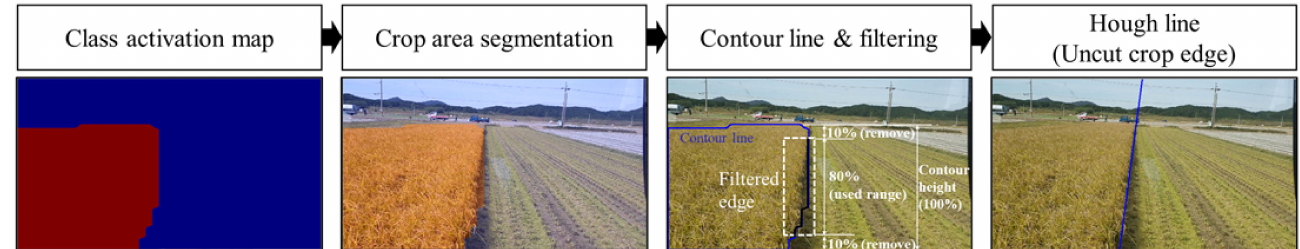
Figure 3. Image processing for determining the uncut crop edge based on segmentation